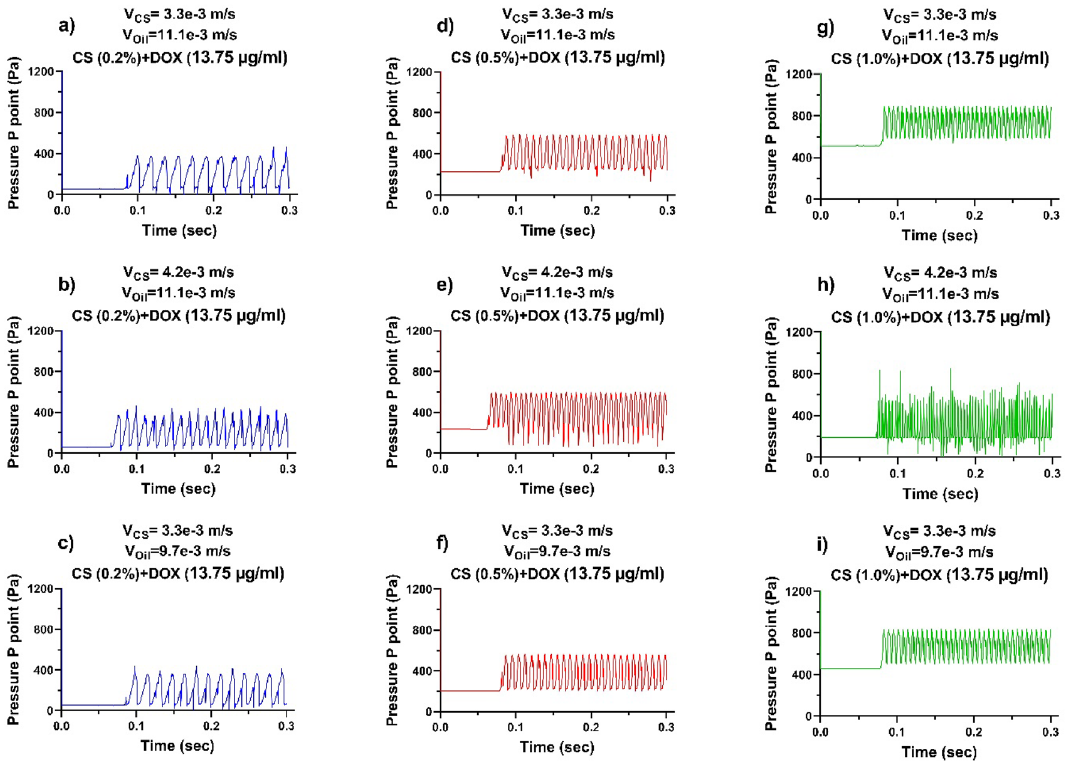
Figure 5. The computer simulation results in the pressure gradient at the P point. Impact of velocities and concentrations of the CS-DOX upon the droplet formation. The velocities of vegetable oil are changeable at 9.7 and 11.1 mm/s, and the CS-DOX velocities are regulated at 3.3 and 4.2 mm/s. The concentration of CS is ( a–c ) 0.2%, ( d–f ) 0.5%, (g–i) 1.0% (w/v), and also the concentration of DOX is 1.375% (w/v).